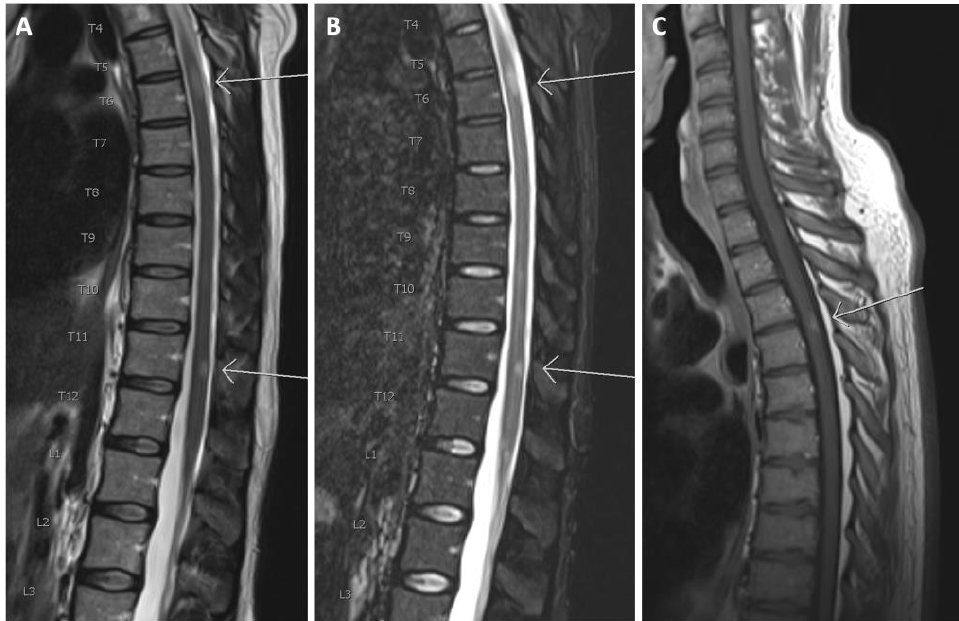
Figure 2. ( A) Sagittal T2 and ( B ) sagittal TIRM of the thoracolumbar spinal cord. Arrows show T2 hyperintense lesions at levels T6 and T11; ( C ) T1 after gadolinium in another patient. The arrow shows a contrast-enhancing lesion at level T3/T4.